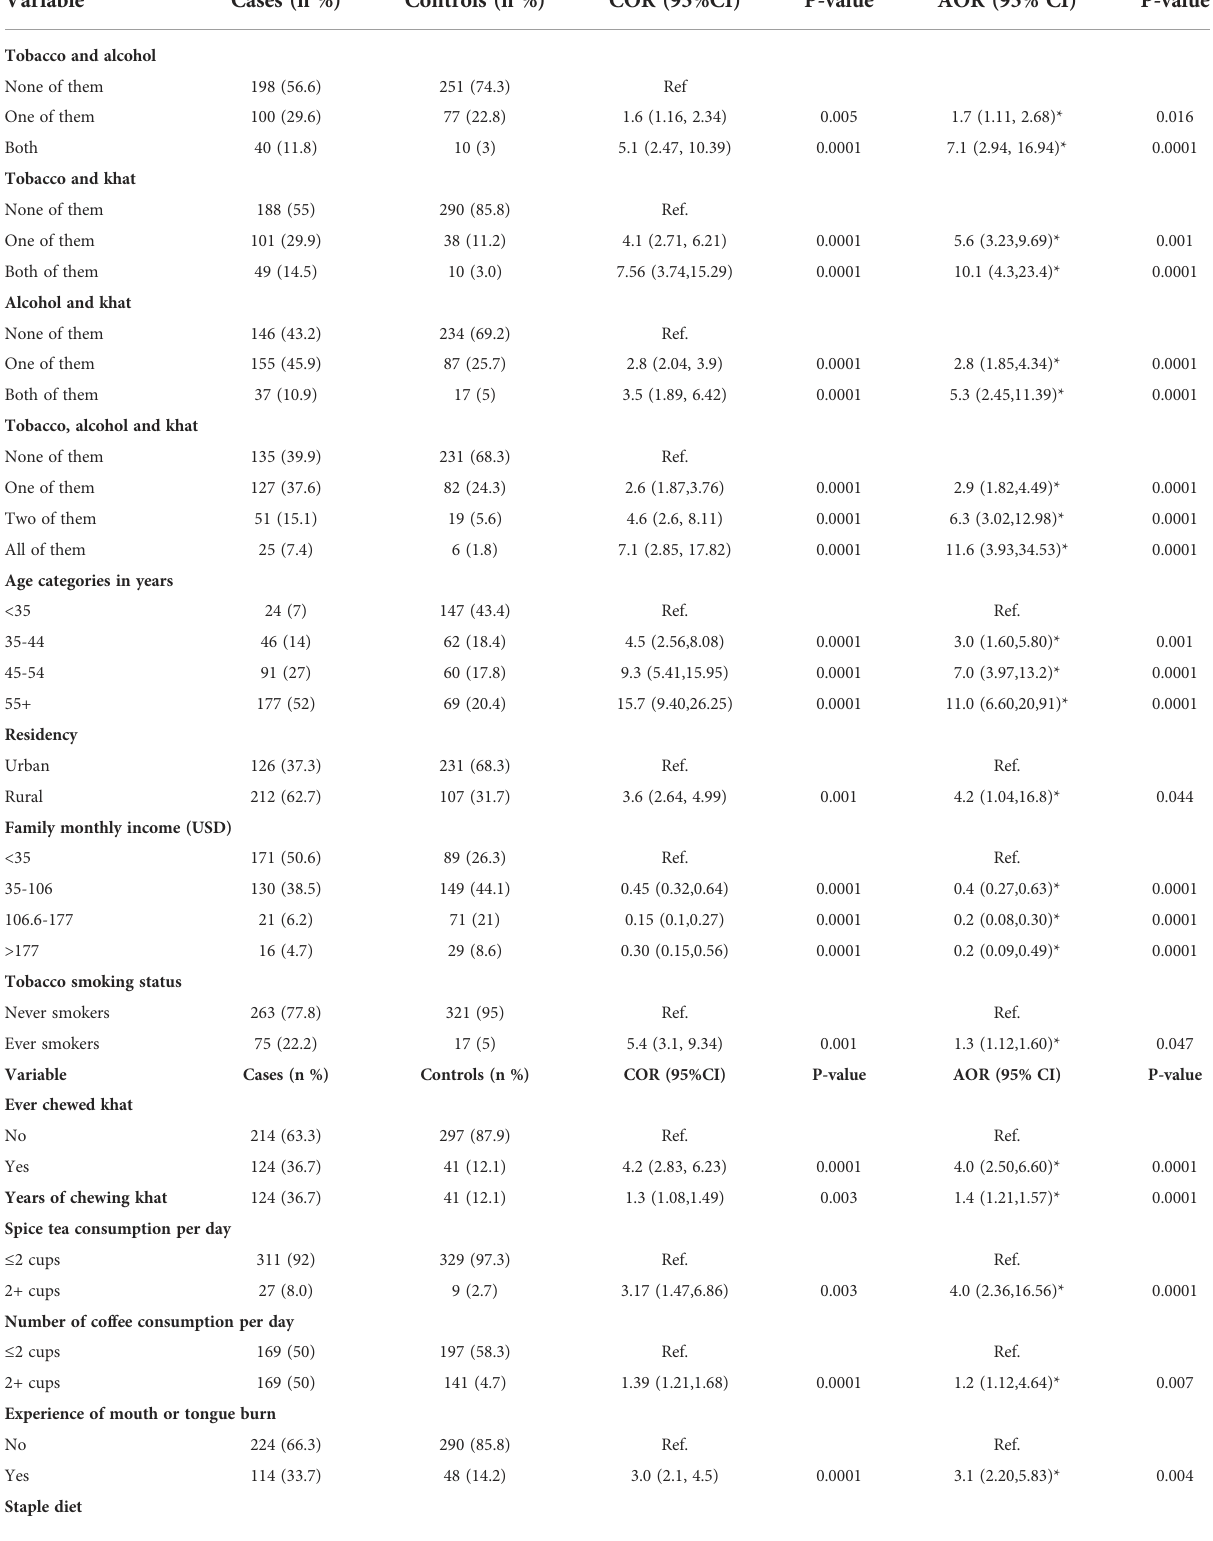
TABLE 5 Statistically signi fi cant variables associated with oesophageal cancer based on hierarchical modeling from February 2019 to August 2020, Addis Ababa,